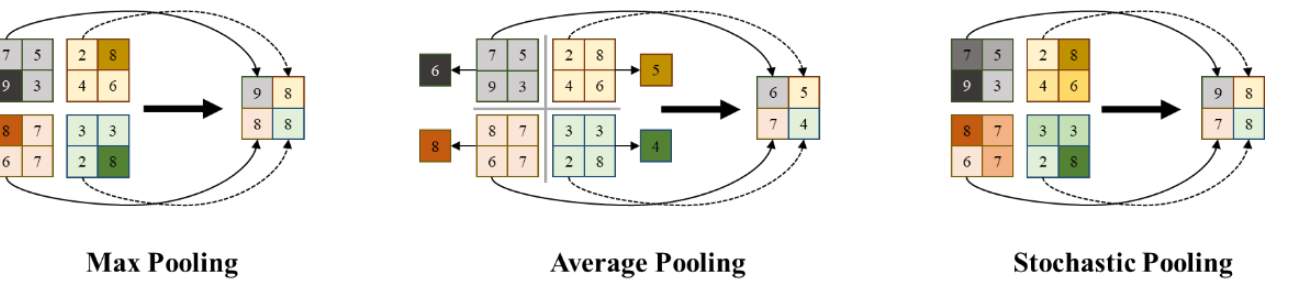
Figure 3. Different pooling strategies in convolutional neural networks.